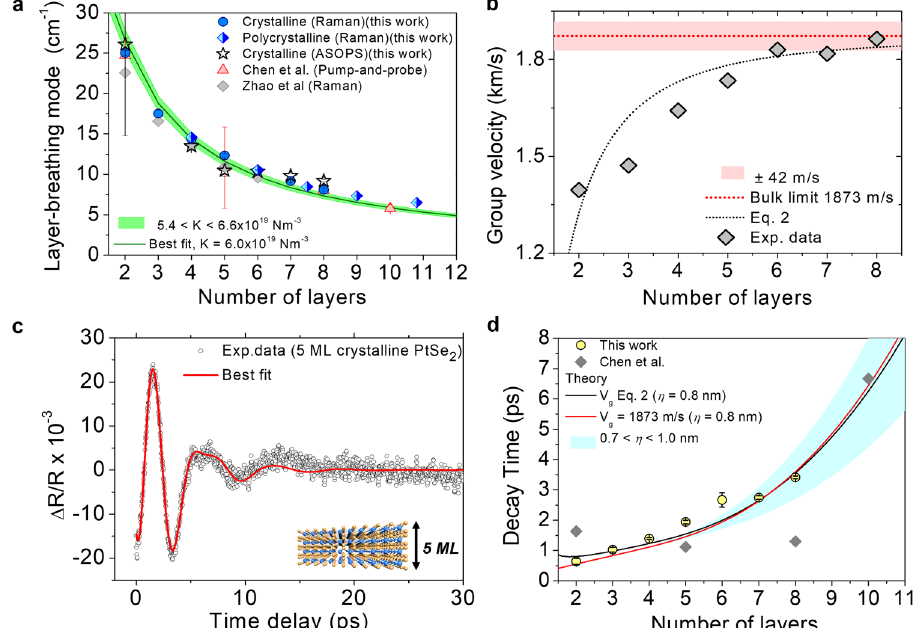
Fig. 2 Phonon dynamics in PtSe 2 . a Peak position of the fi rst order breathing mode measured in crystalline and polycrystalline PtSe 2 fi lms using low-frequency Raman spectroscopy and ASOPS as a function of the number of layers and comparison with other experimental works. b Calculated group velocity as a function of the number of layers. c Representative transmission signal obtained with ASOPS in 5 ML PtSe 2 (black open circles) and the best fi t (red line). d The extracted phonon decay time (yellow dots) vs the number of layers. The red and black curves are theoretical predictions of the phonon lifetimes based on the model proposed by Ziman 30 . The region displayed with light blue shows the impact of roughness in the calculated lifetimes. The gray data points show phonon lifetimes measured by Chen et al. 18